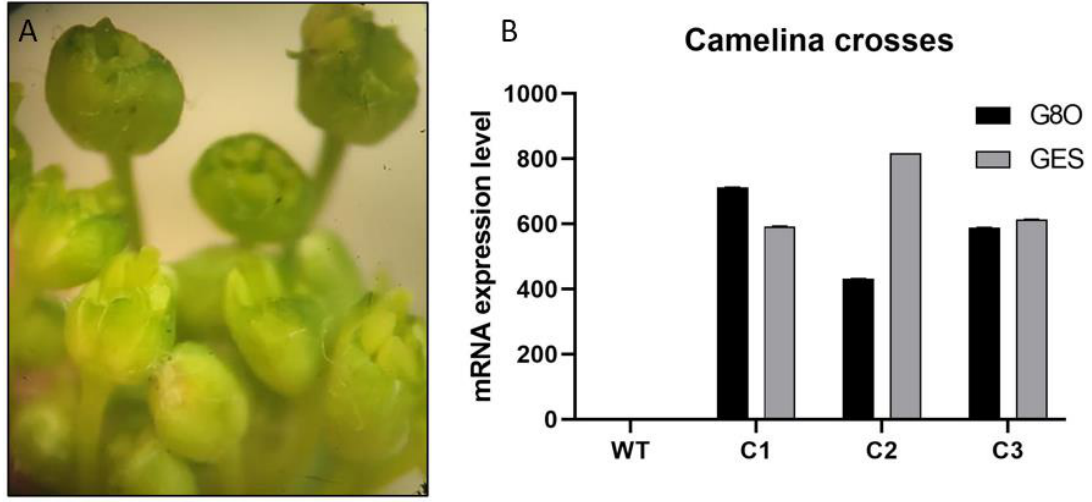
Figure 8. ( A ) Emasculated Camelina flower buds used as the female part in crossing. ( B ) GES and G80 relative mRNA expression to WT in F1 Camelina crosses using ACT2 as a house keeping gene. GES and G80 are transgenes originating from Catharanthus roseus , inherited from female and male parental plants respectively, while ACT2 is an actin gene from Camelina. C1, C2 and C3 are three of the 15 crosses that survived BASTA selection.